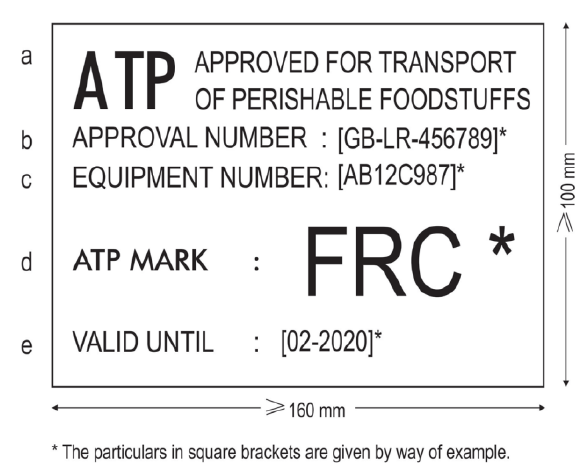
Figure 1: Certification plate of compliance of the